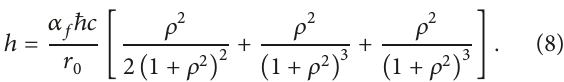
Figure 2: (a) Scheme of the hedgehog configuration (5). The small blue arrows show the imaginary part field in an arbitrary plane through the origin. The long magenta lines indicate the electric field lines of a point charge, the lines of constant 󳨀→ 𝑛 -field. (b) Half-sphere covered by the hedgehog